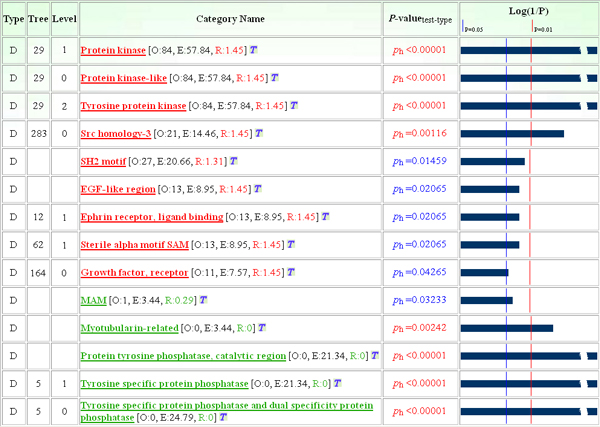
GFINDer Statistics Protein Familes&Domains module: protein domain analysis. InterPro protein domains most significantly over- (red) and under-represented (green) in the considered tyrosine kinase versus tyrosine phosphatase gene classes; Type: type of InterPro entry (D: protein domain); Tree: tree label in the defined protein domain parent/child hierarchy, if any; Level: level in the related tree of the defined protein domain parent/child hierarchy, if any (higher levels correspond to more specific protein domains); P-valuetest-type: p value defining relevance of a given protein domain (Category Name) for a considered class of genes, and initial of used statistical test name (h: hypergeometric distribution test).